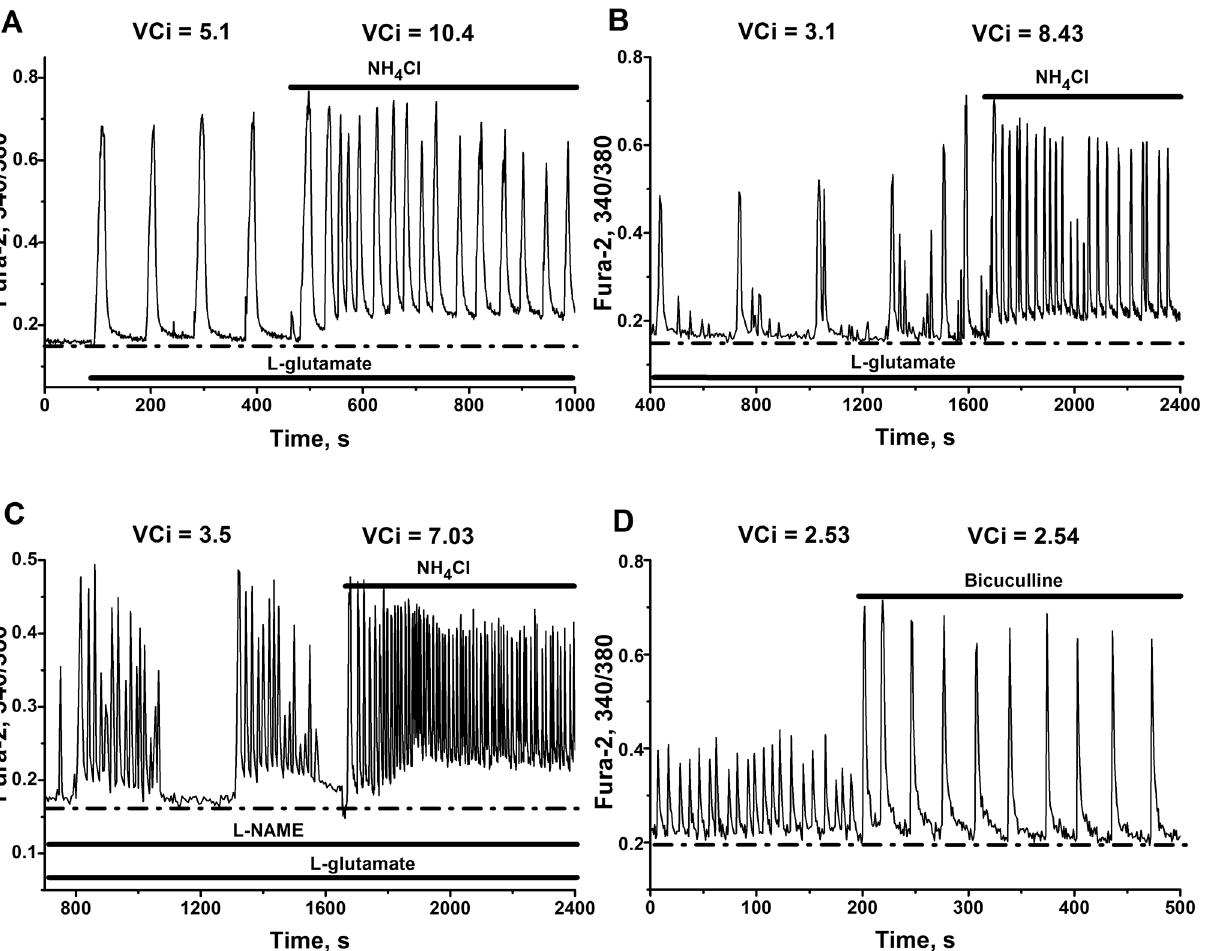
Fig 2. Transformation of simple and complex intracellular Ca 2+ -oscillations into high-amplitude impulse-shaped Ca 2+ -oscillations by NH 4 Cl or bicuculline. Neuronal cultures 12 DIV. Resting calcium level is outlined by dot-dashed lines. Calcium increment over resting level (VCi = Δ Ca (a.u.)/min) is indicated on the Figures as VCi. All other abbreviations as on Fig 1. Total number of neuronal cells in networks are: N = 116, 132, 98, 110 for Fig A, B, C and D, correspondingly. (A – C) NH 4 Cl induces high-amplitude Ca 2+ -oscillations in representative cells. 200 nM of L-glutamate was added before application of NH 4 Cl. (C) The experiment was performed in the presence of 10 μ M L-NAME and 200 nM of L-glutamate. (D) 10 μ M of bicuculline evokes high-amplitude Ca 2+ -oscillations in spontaneously firing cell. Only parts of total records are presented on Fig B and C. Initial parts were omitted for